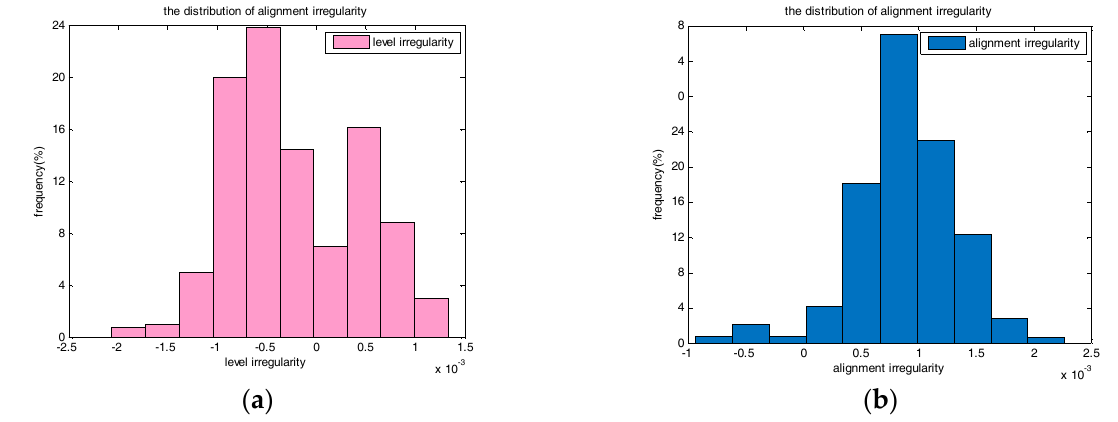
Figure 12. ( a ) The distribution of level irregularity measurement accuracy; ( b ) The distribution of alignment irregularity measurement accuracy.